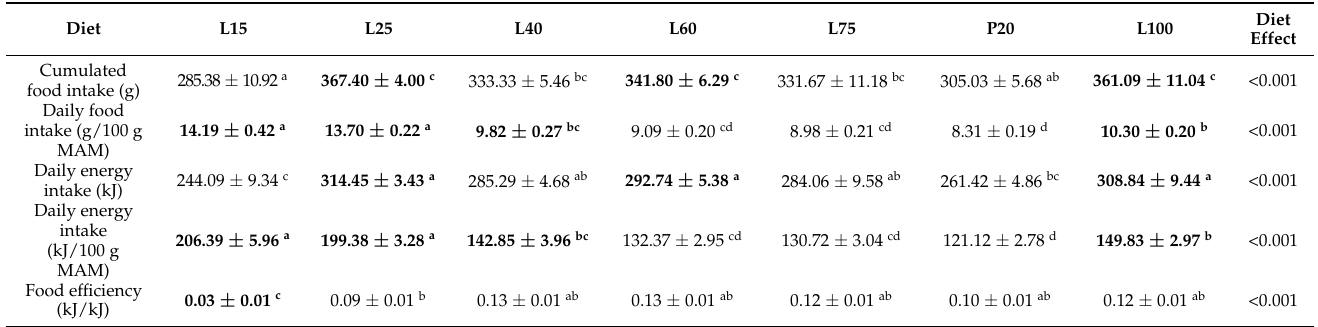
Table 1. Absolute and relative values of energy and food intake for lysine diets.